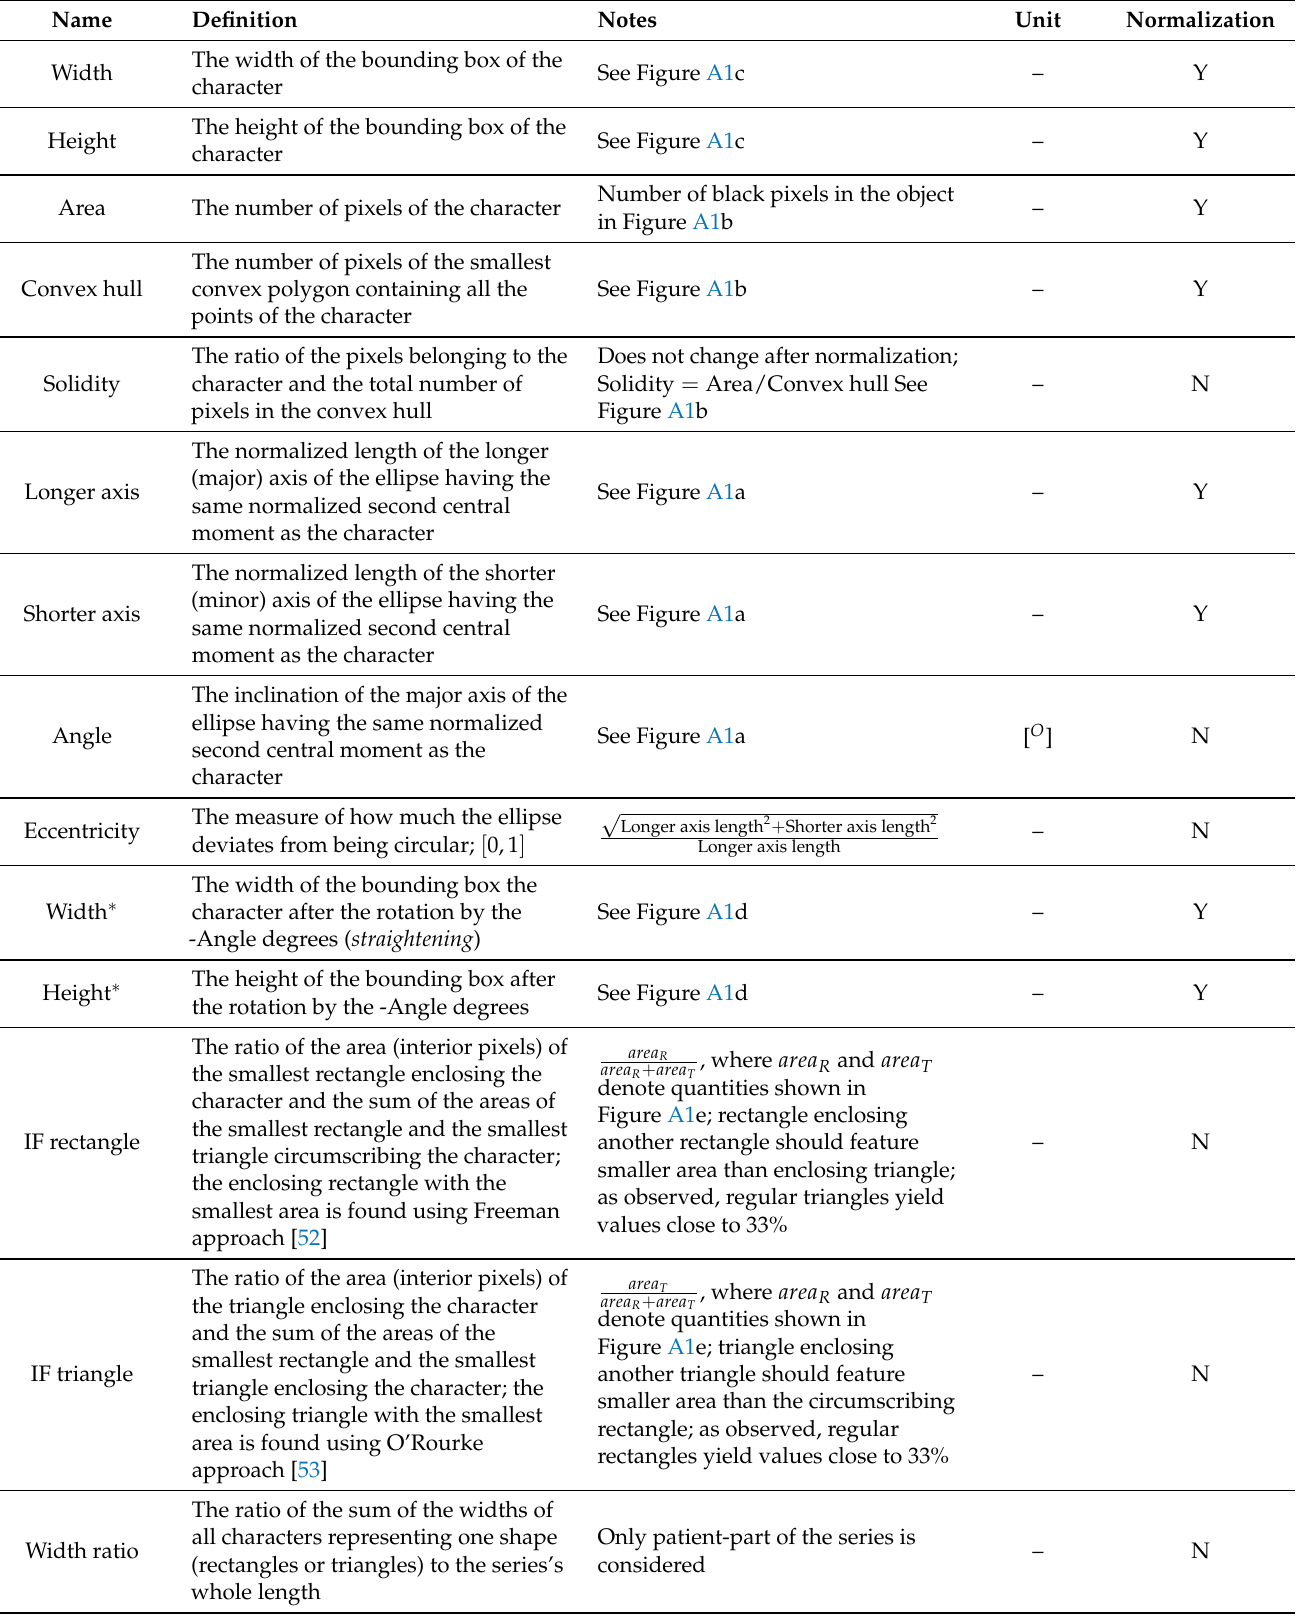
Table A1. Image-related features; features extracted after rotation are marked with *.